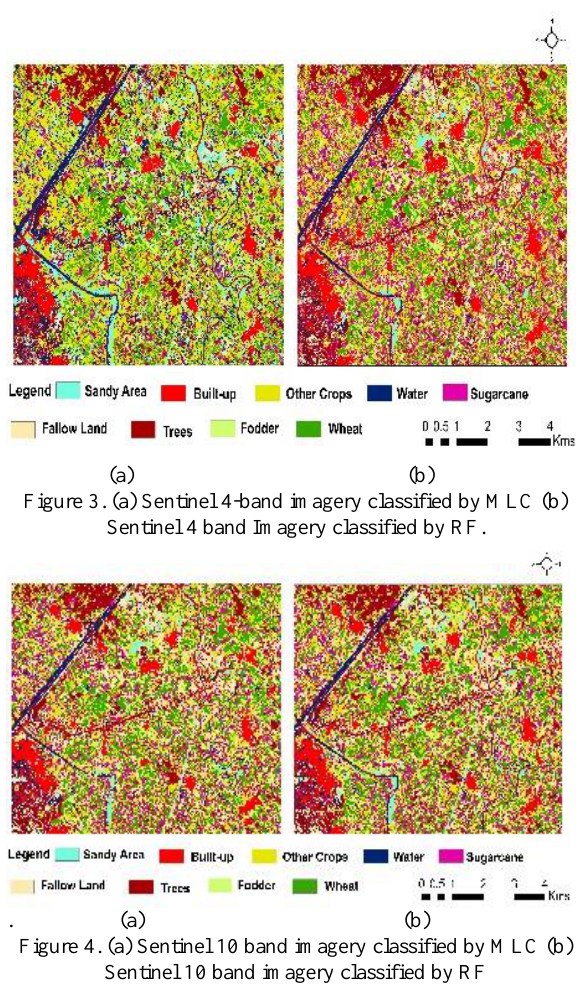
Figure 4. (a) Sentinel 10 band imagery classified by MLC (b) Sentinel 10 band imagery classified by